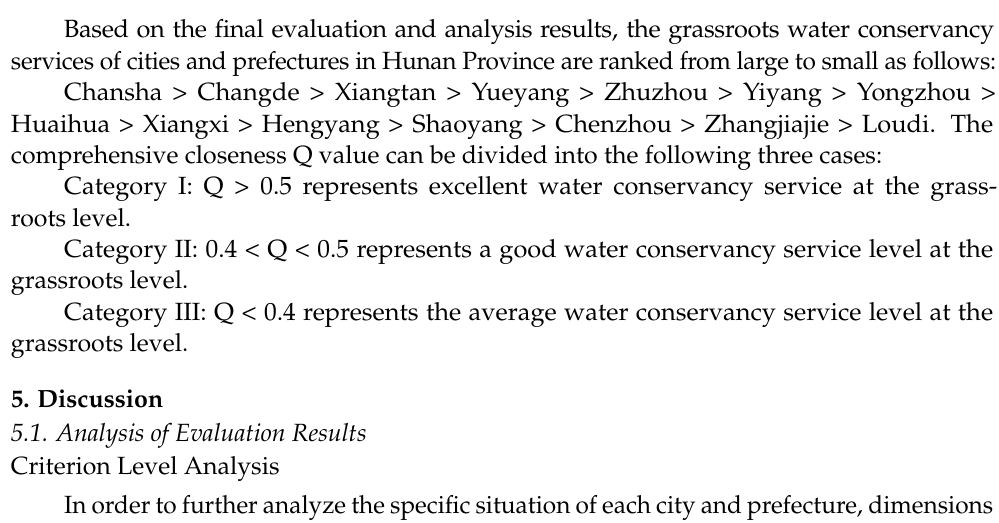
Figure 3. Result of closer degree of each city in Hunan Province.